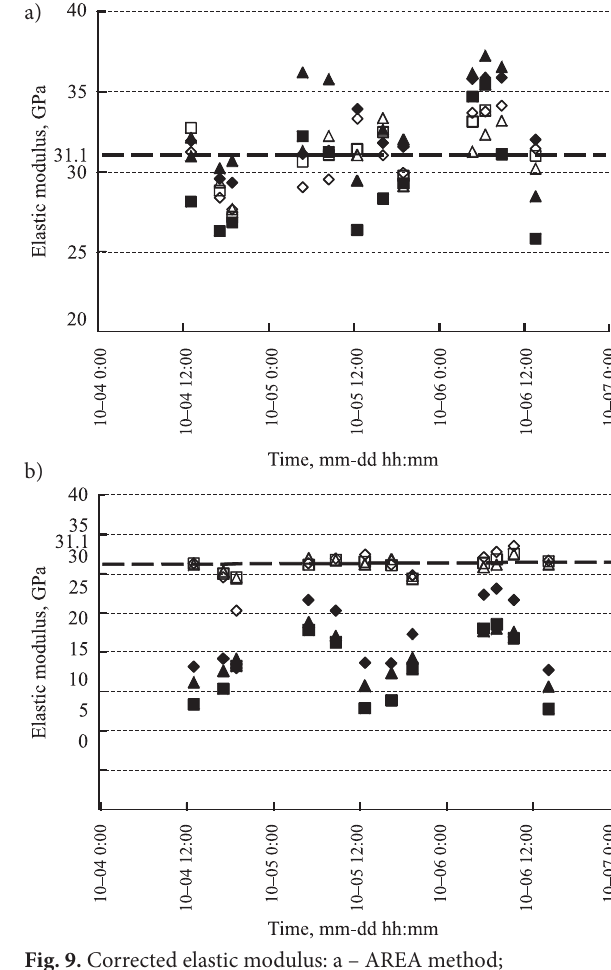
Fig. 9. Corrected elastic modulus: a – AREA